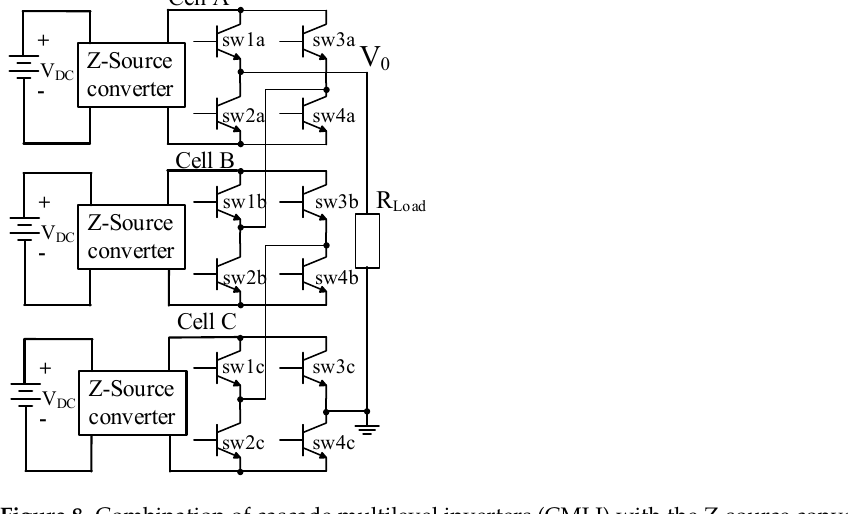
Table 1. Possible cases of CMLI with fault tolerance. Condition